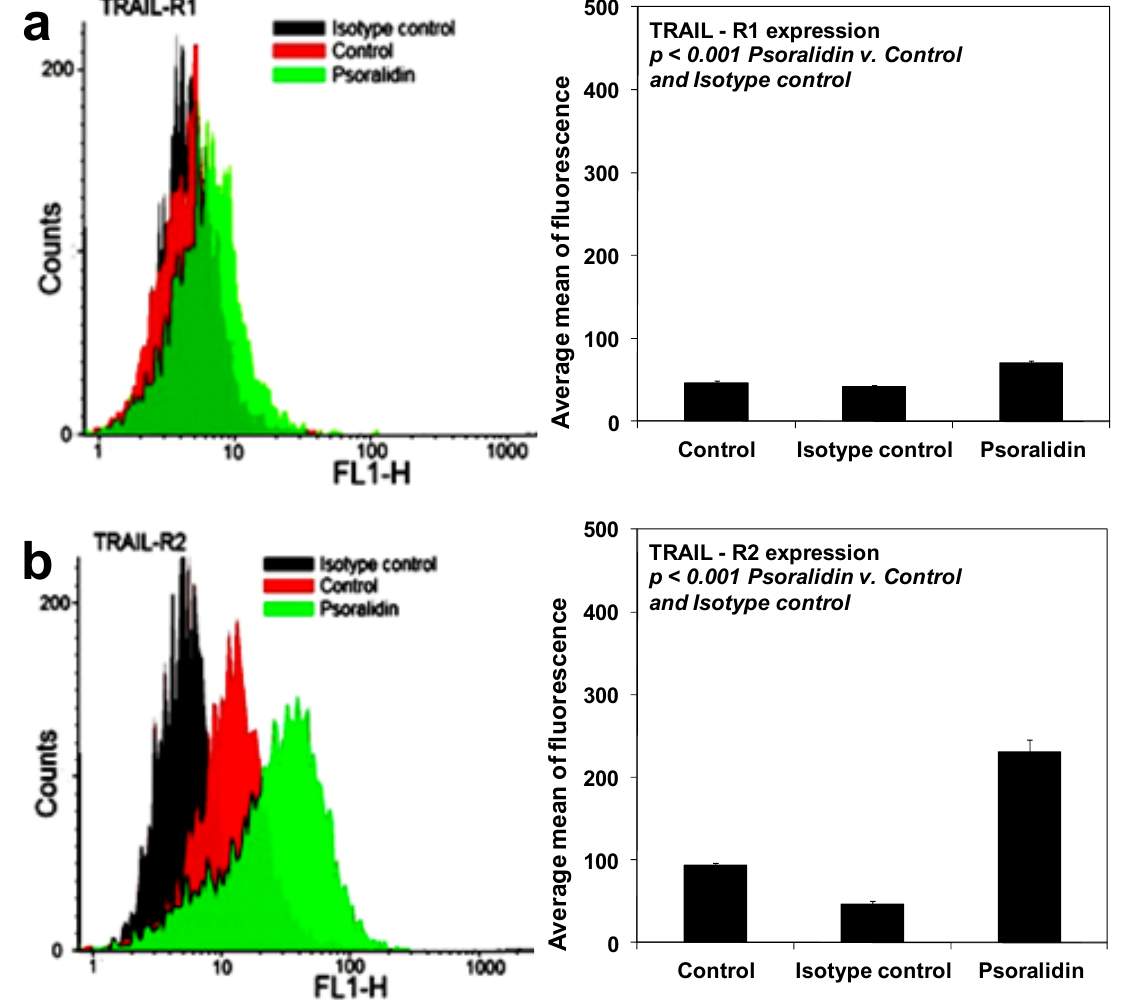
Figure 6. Effects of psoralidin on death receptor expression in HeLa cancer cells. Cells were incubated for 48 h with psoralidin at the concentration of 50 μ M. The surface expression of ( a ) TRAIL-R1 and ( b ) TRAIL-R2 on cancer cell was measured by flow cytometry. The values represent mean ± SD of three independent experiments performed in duplicate (n =